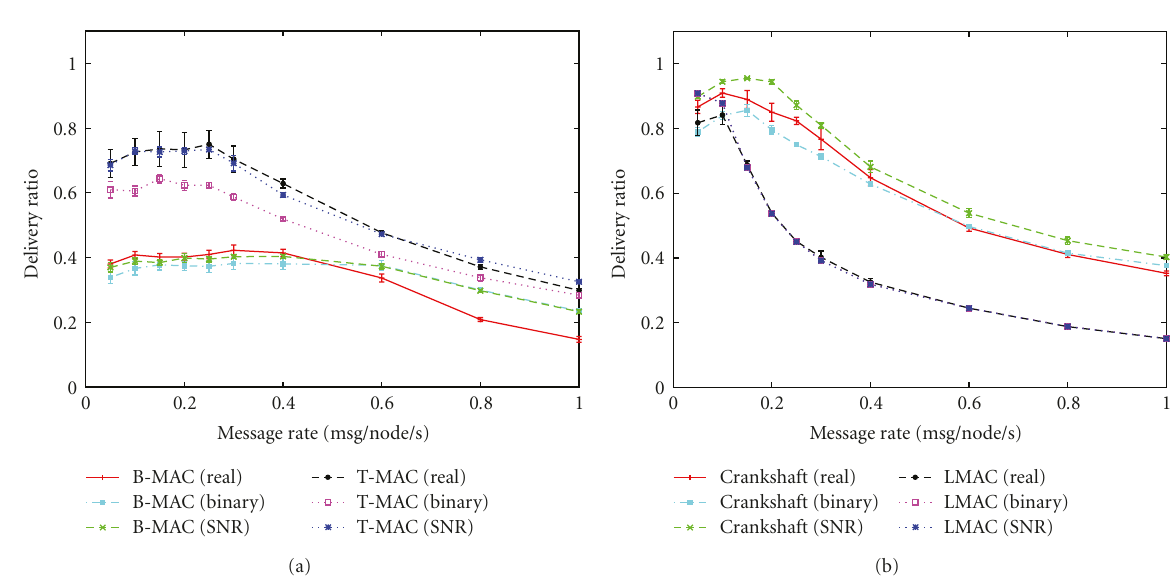
Figure 7: Delivery ratio for simulated and real convergecast experiments. with the sink at the edge of the